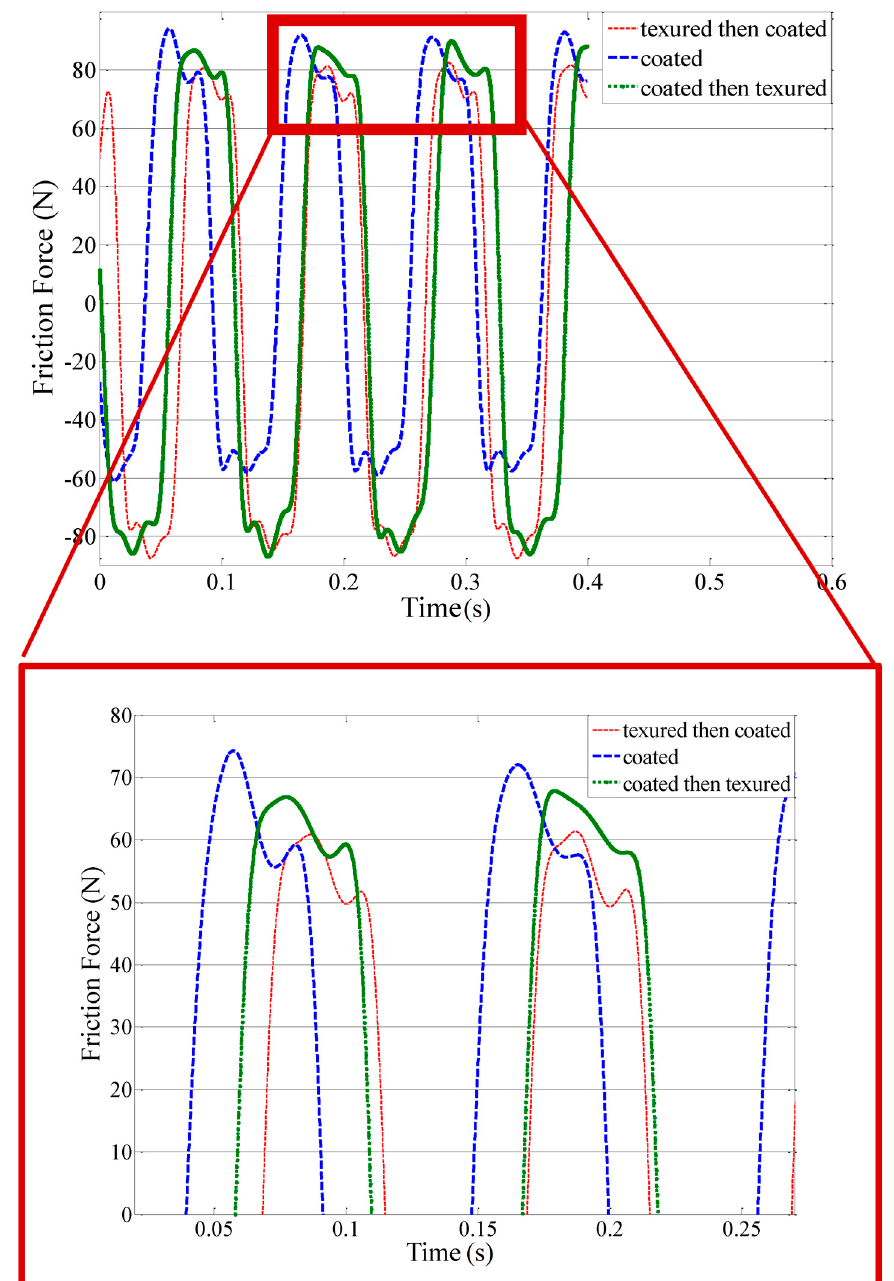
Figure 6. Magnified picture of friction force versus time at speed of 600 rpm for coated, coated and textured, and textured and coated rings.